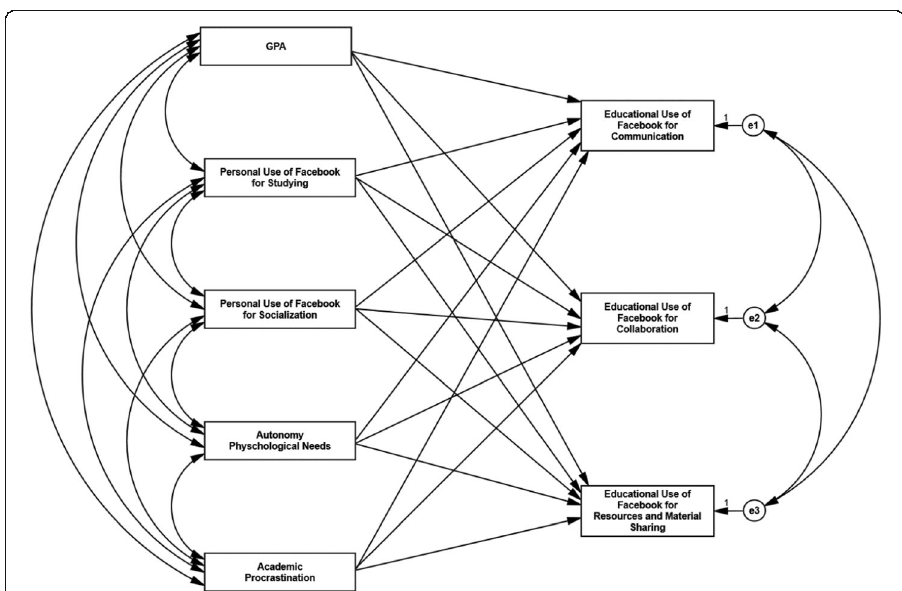
Table 4 Assessment of normality Variable Skewness Critical GPA −